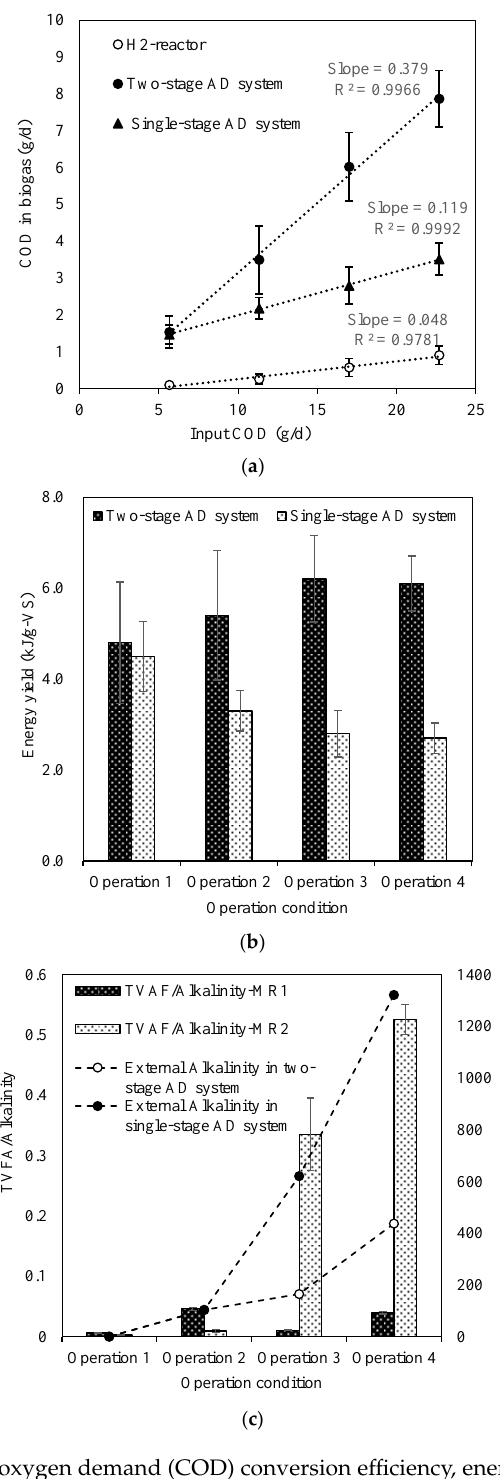
Figure 7. The chemical oxygen demand (COD) conversion e ffi ciency, energy yield, TVFA / alkalinity and additional alkalinity in single-stage and two-stage AD system at various operation conditions. ( a ) COD conversion e ffi ciency; ( b ) Energy yield; ( c ) TVFA / alkalinity and additional